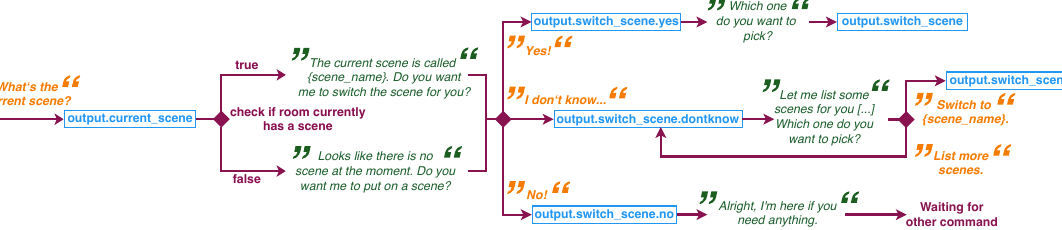
Figure 5. Possible interaction dialog with advanced agent for Current scene action. Orange: User input; Green: Agent output; Blue: recognized